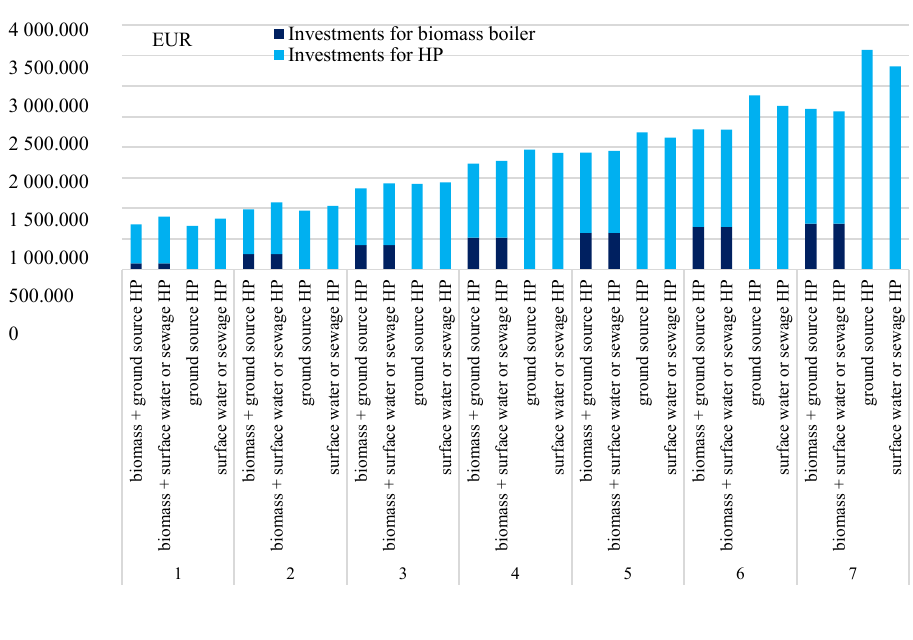
Fig. 5. Required investments for each group for both